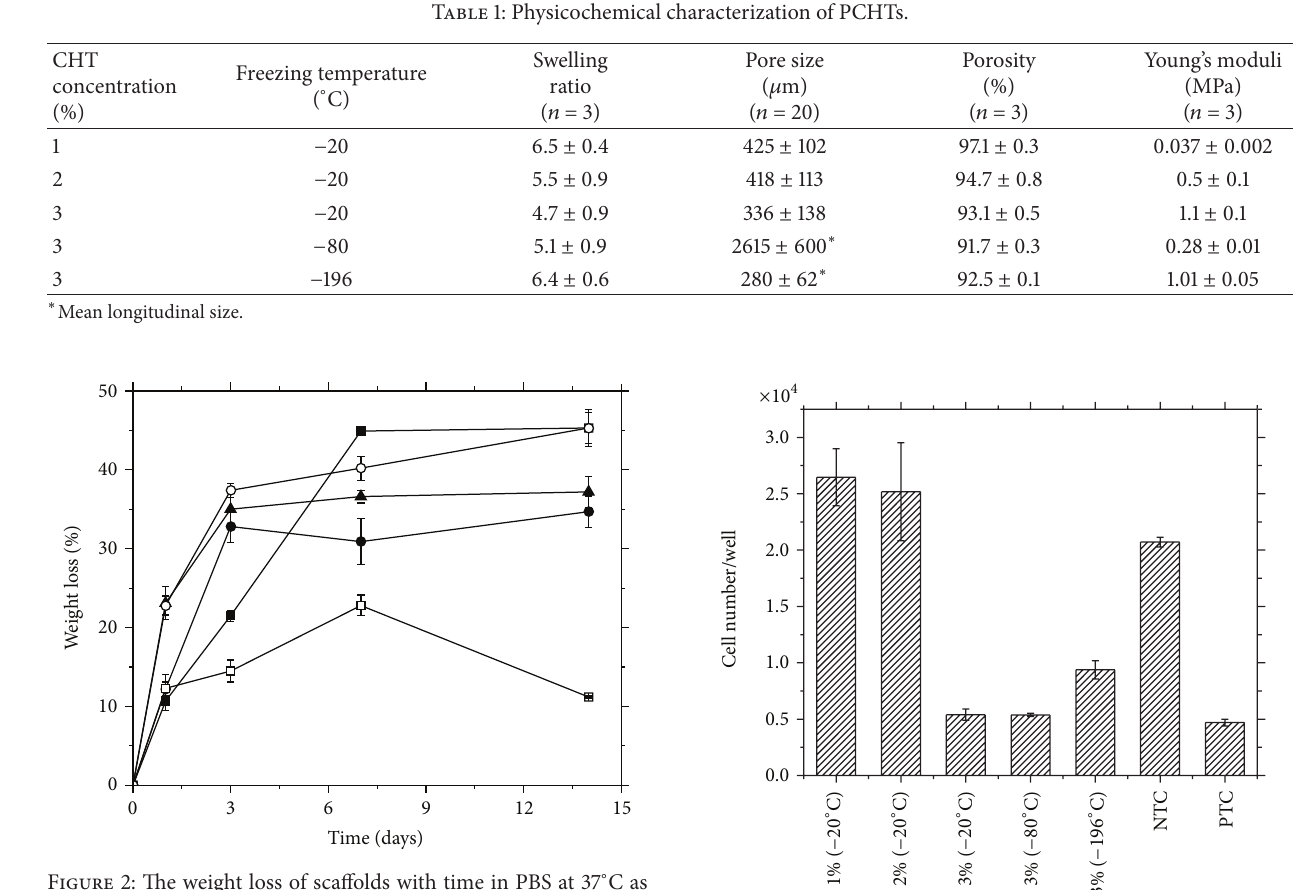
Figure 2: The weight loss of scaffolds with time in PBS at 37 ∘ C as a percentage of the original weight of the scaffold ( 𝑛 = 3 ). The data are plotted with the means ± standard error. ( ◼ ) PCHTs 1% ( − 20 ∘ C); ( e ) PCHTs 2% ( − 20 ∘ C); ( 󳵳 ) PCHTs 3% ( − 20 ∘ C); ( ◻ ) PCHTs 3% ( − 80 ∘ C); and (O) PCHTs 3% ( − 196 ∘ C). Figure 3: Proliferation of h-AdMSCs exposed to the PCHTs scaffolds after 24 hours of cultivation. Negative control (NTC) = DMEM with 10% FBS; positive control (PTC) = DMEM with phenol 0.5%. Mean ± standard deviation 𝑛 = 3 . The population means are significantly different from positive control at ∗ 𝑃 < 0.05